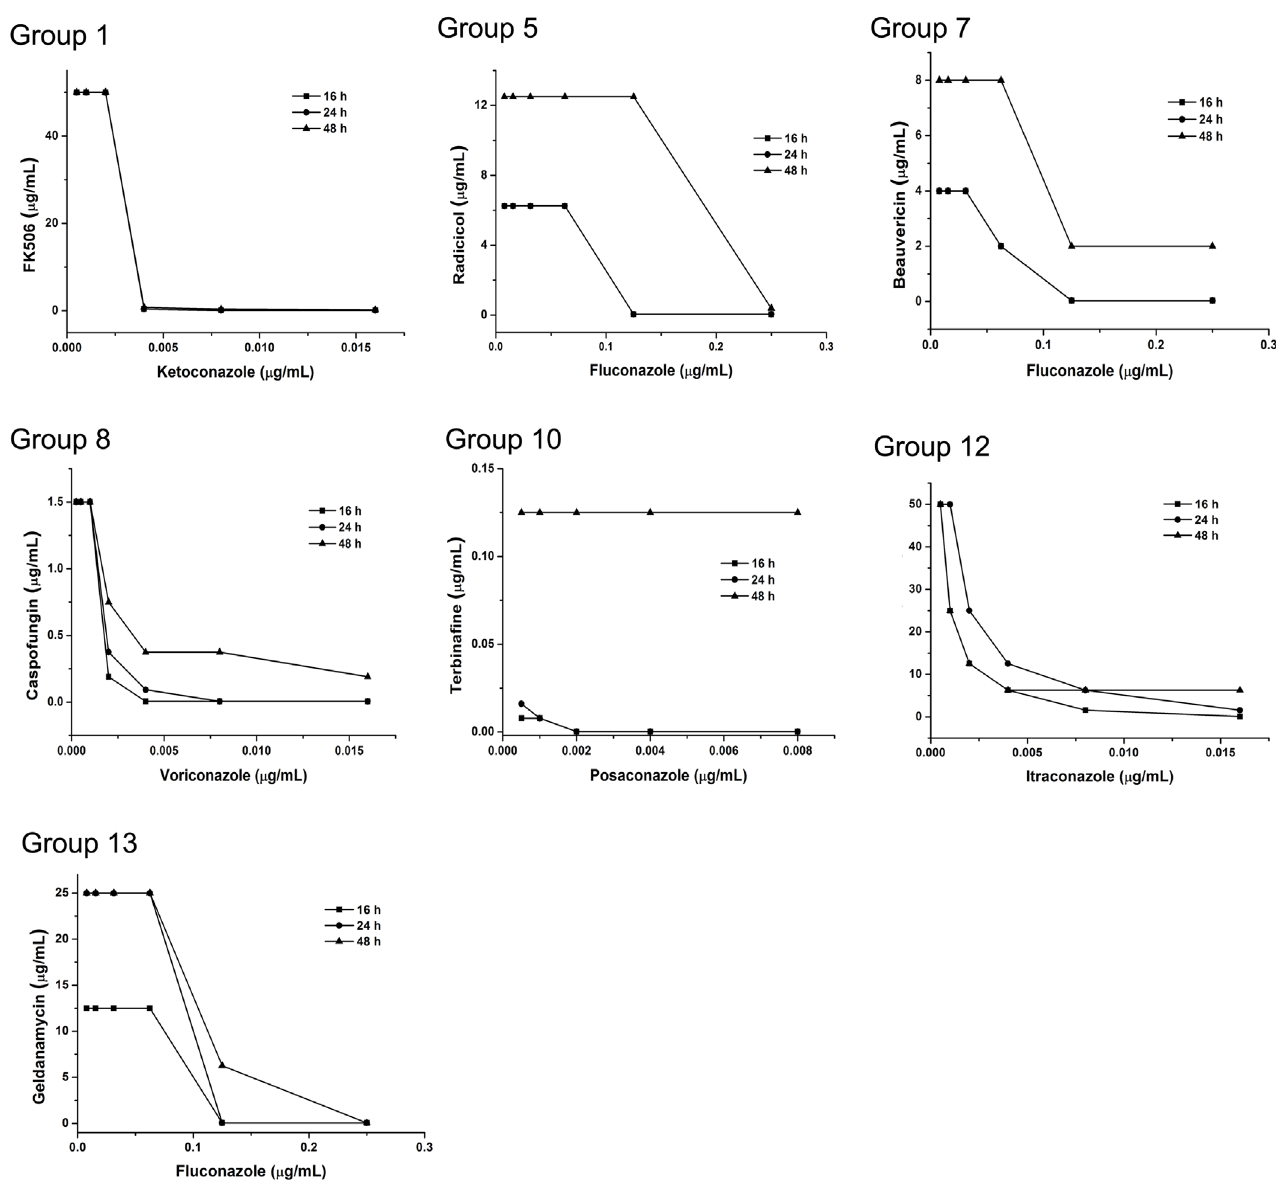
Fig 6. Synergistic antifungal combinations: The x and y axis indicated the concentrations of the combination drugs used in the synergistic screening. The dots were the active concentrations for inhibiting the growth of C. albicans in the combinations. All experiments were performed on 96-well plates and incubated at 35 oC for 48 h. The data from three independent experiments were measured at different time points (16 h, 24 h and 48 h).